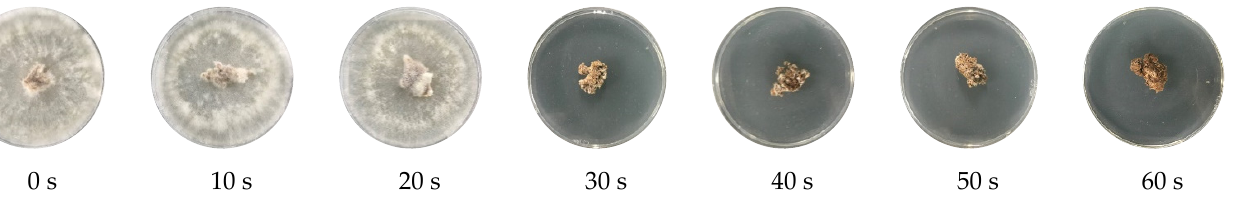
Figure 3. Center and internal temperature profiles of 500 g of solid-state fermented W. cocos product during RF with a gap of 15 cm, pasteurization of 1 min, and cooling.